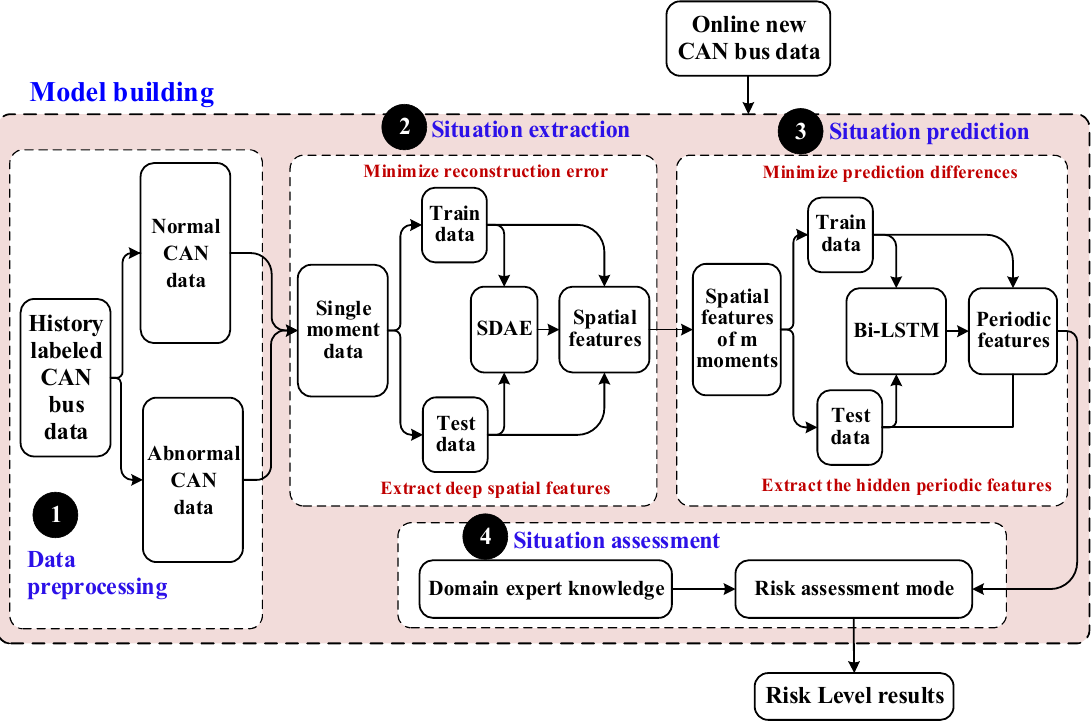
Figure 5. SDAE+Bi-LSTM (SDBL)